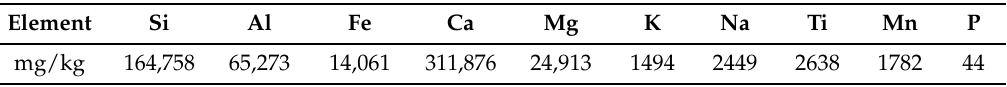
Table 2. Concentration of elements (mg/kg) in BFS (calculated by XRF results from Table 1). Element Si Al Fe Ca Mg K Na Ti Mn P mg/kg 164,758